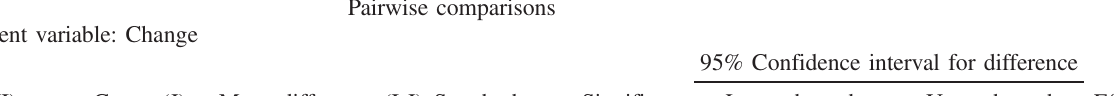
TABLE XIII. A pair wise comparison between the experimental group and the control group (end of the winter 2015 semester) for the justification of knowledge factor in winter 2015.